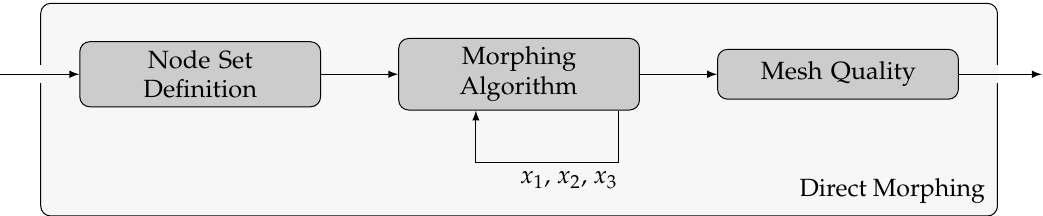
Figure 3. Detailed Direct Morphing process from Figure